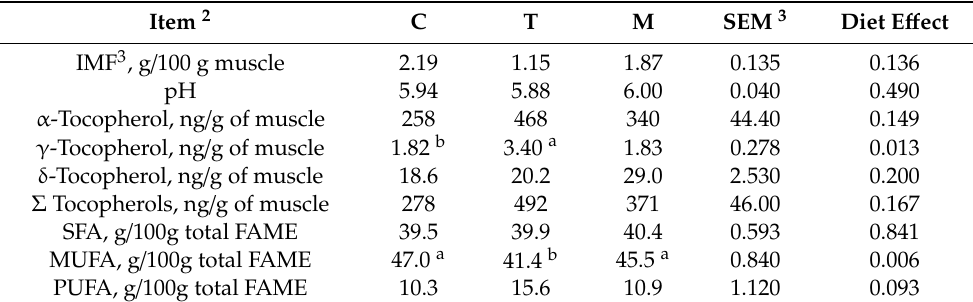
Table 2. E ff ect of the dietary treatment 1 on meat quality